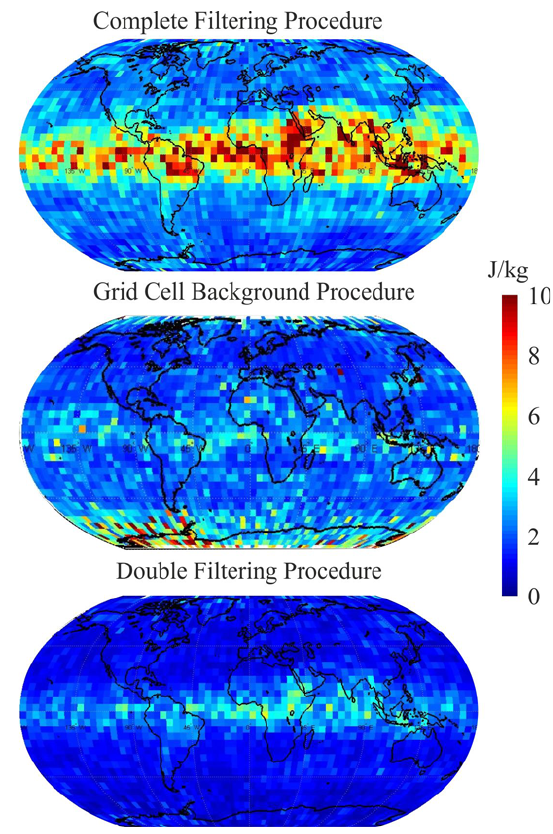
Fig. 9. Average potential energy per 5 × 5 ◦ cells between 5km and 35km height by the double filtering method, the grid cell back- ground procedure and the complete method, based on global COS- MIC GPS RO data from June